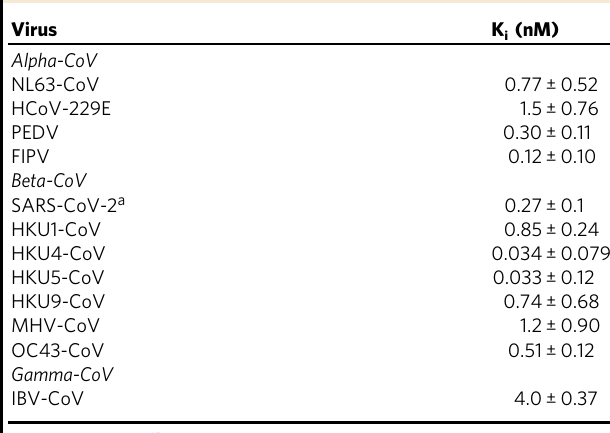
Table 1 Activity of PF-00835231 against 3CL pro of coronaviruses (mean ±